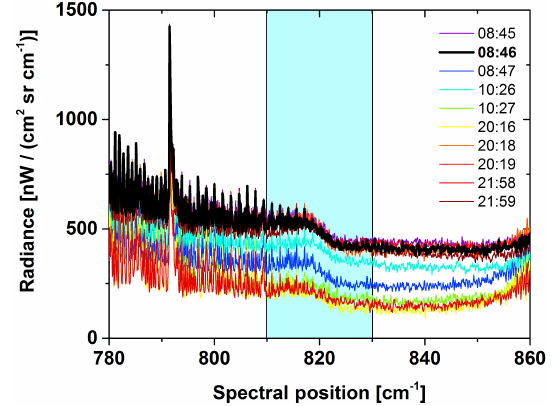
Figure 5. Spectral window of MIPAS-Envisat channel A observa- tions with tangent altitudes between 18.4 and 19.0km in the vicinity of the Geophysica flight on 11 December 2011. Geolocations are in- dicated in Fig. 1. Observation times are given in UTC.